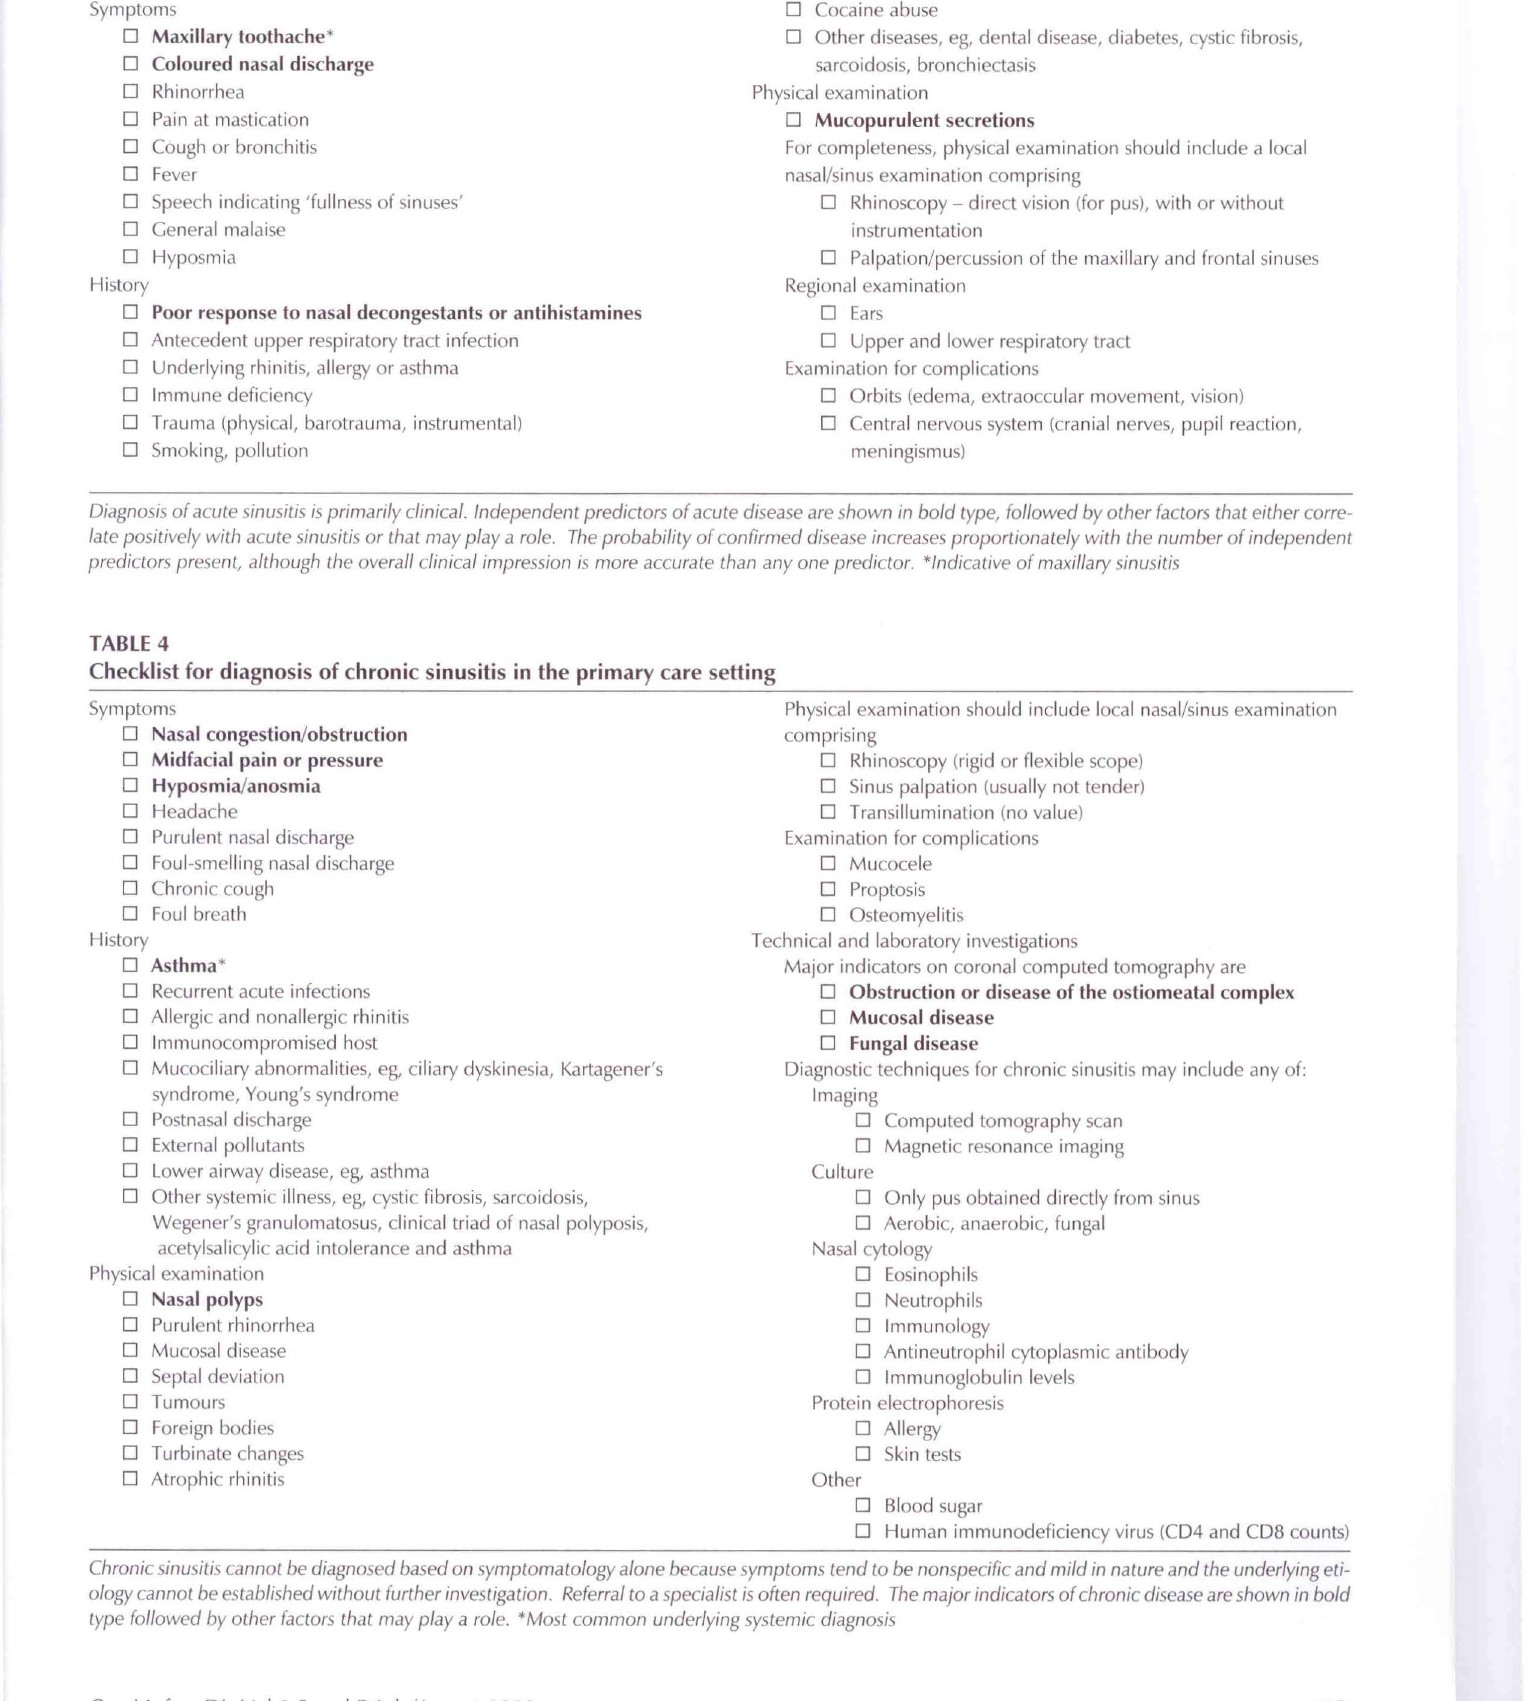
Checklist for diagnosis of acute sinusitis in the primary care setting